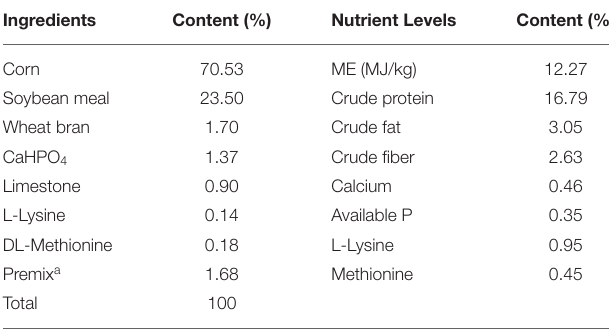
TABLE 1 | Composition and nutrition levels of the basal diet.